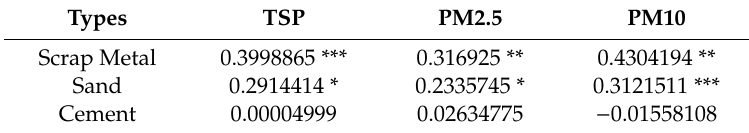
Table 1. Correlation between the primary cargo throughput and fine dust concentrations.